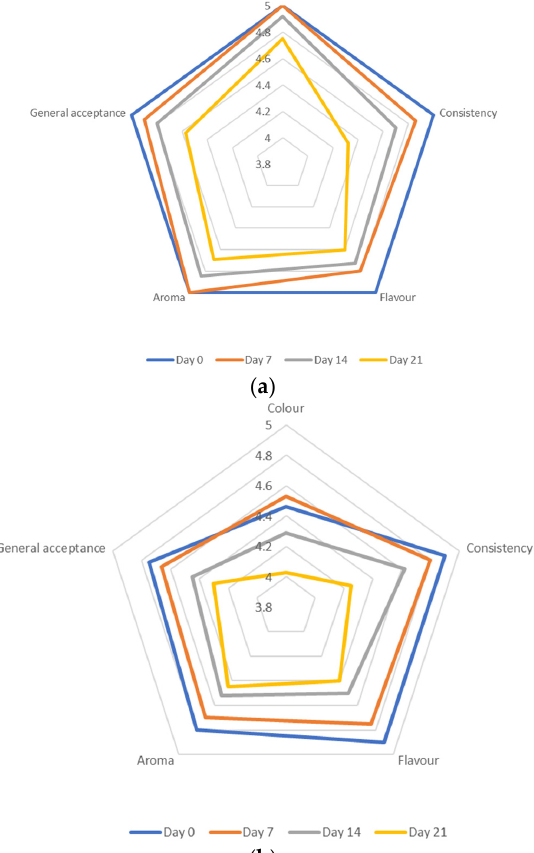
Figure 3. ( a ) Changes in sensory quality (colour, consistency, flavour, aroma, and general acceptance) of the plain, natural yoghurts during 21 days of storage in the refrigerated conditions. ( b ) Changes in sensory quality (colour, consistency, flavour, aroma, and general acceptance) of the yoghurts with sea buckthorn fruit mousse during 21 days of storage in the refrigerated conditions.